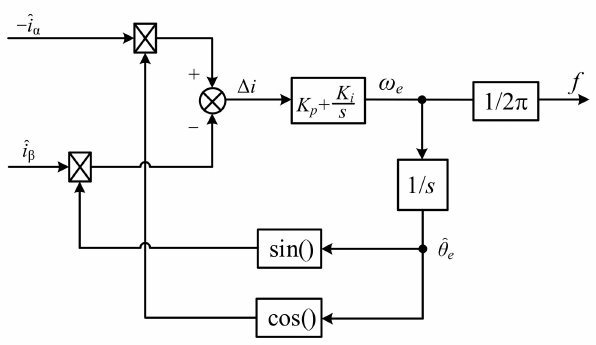
Figure 3. Stator current frequency detection block diagram based on